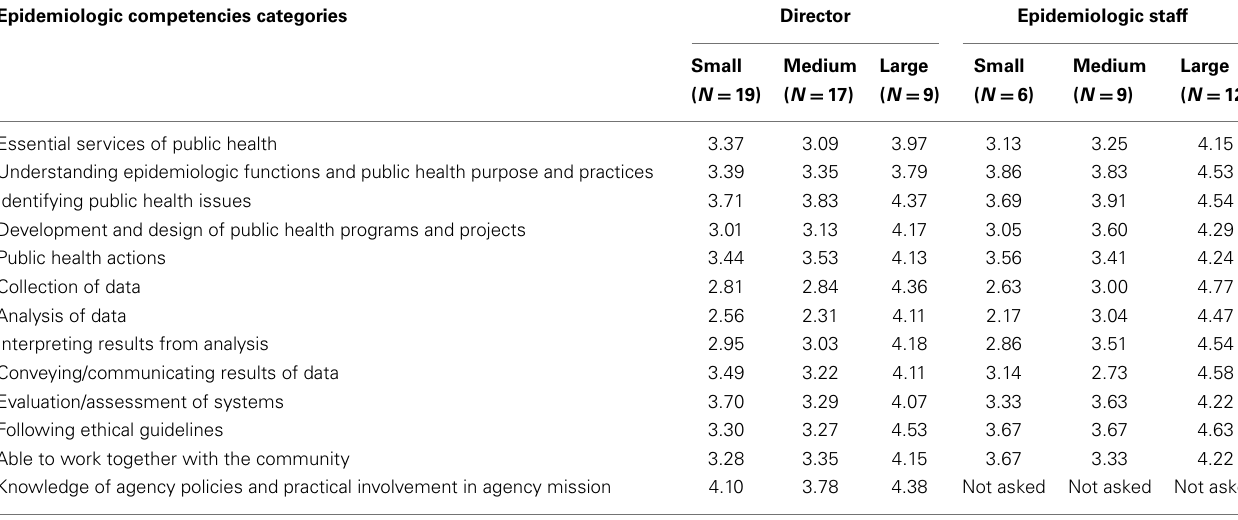
Table 4 |Average scores in confidence of directors and epidemiologic staff members of local health departments in categories of collapsed epidemiologic competencies